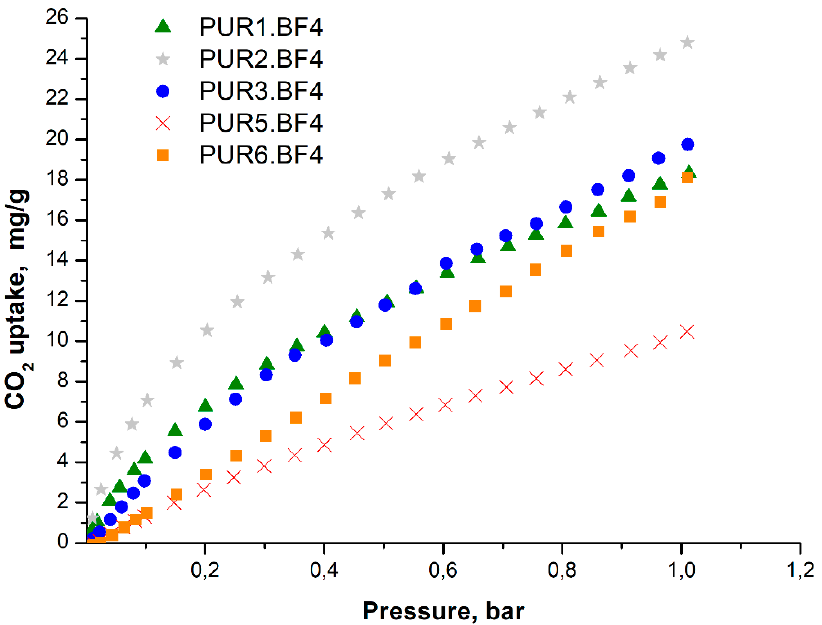
Figure 2. CO 2 gas absorption isotherms of ionic PURs at 0 °C.